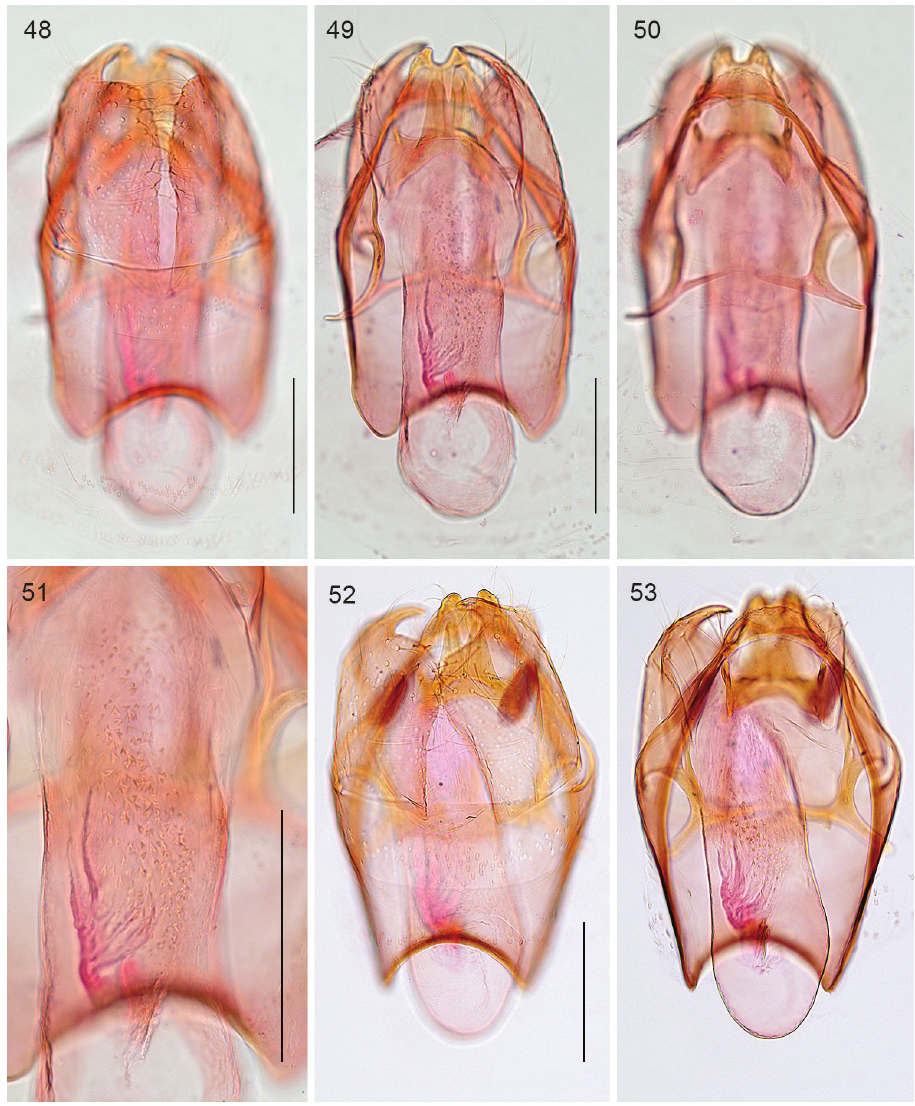
EvN4218. Scale bars:100 µm. Distribution. Peru: Lima. DNA barcode. We barcoded three specimens: the Holotype, the female RMNH. INS.24219 and the male RMNH.INS.24812. BIN: BOLD:ACG9223. The female was also sequenced for other genes and used in the molecular phylogeny (Doorenweerd et al. 2016). Sequences may be retrieved in BOLD and Genbank under voucher/sample ID